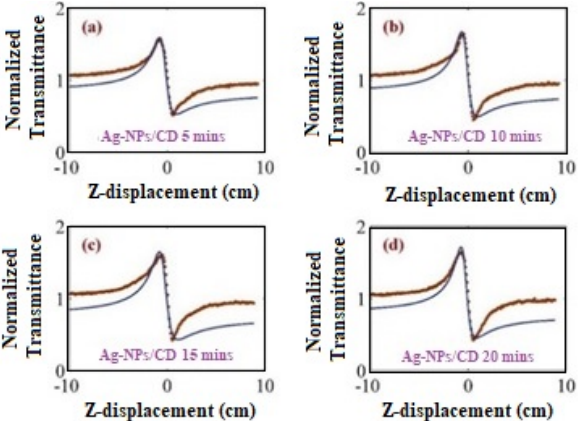
Figure 8. The Z-scan results show the variation of transmittance of the laser beam with the distance for the different ablation time of Ag–NPs/CD solution. ( a ) 5 min, ( b ) 10 min, ( c ) 15 min, and ( d ) 20 min. Table 3. The nonlinear refractive index and real part of nonlinear optical susceptibility.